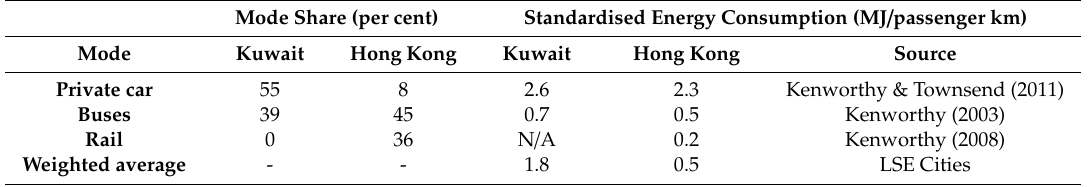
Table 6. Mode share and standardised energy consumption in Kuwait and Hong Kong: MJ per passenger kilometre per day.